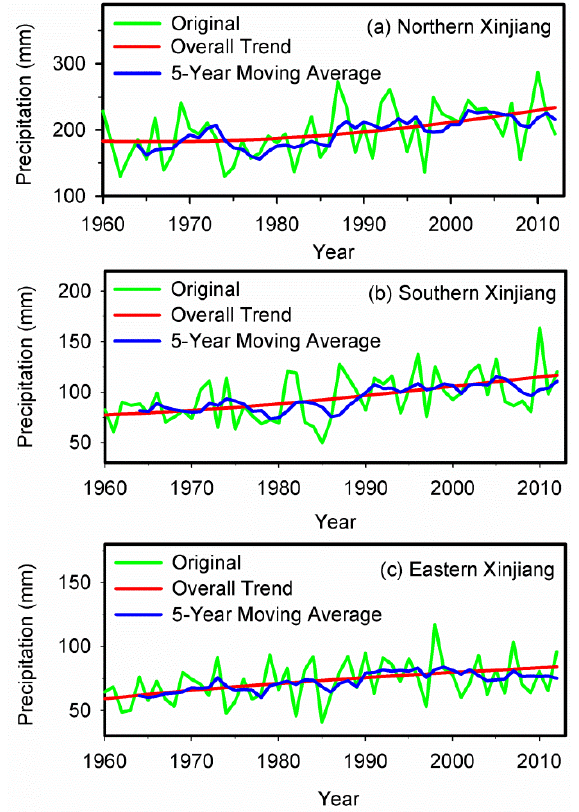
Figure 11. The original average annual precipitation time series and overall trends in ( a ) northern; ( b ) southern and ( c ) eastern Xinjiang during 1960–2012.